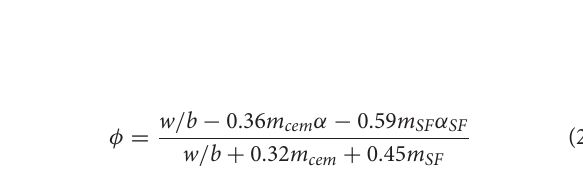
FIGURE 9 | Comparison of pore structure of SF incorporated cement pastes at early and late ages.